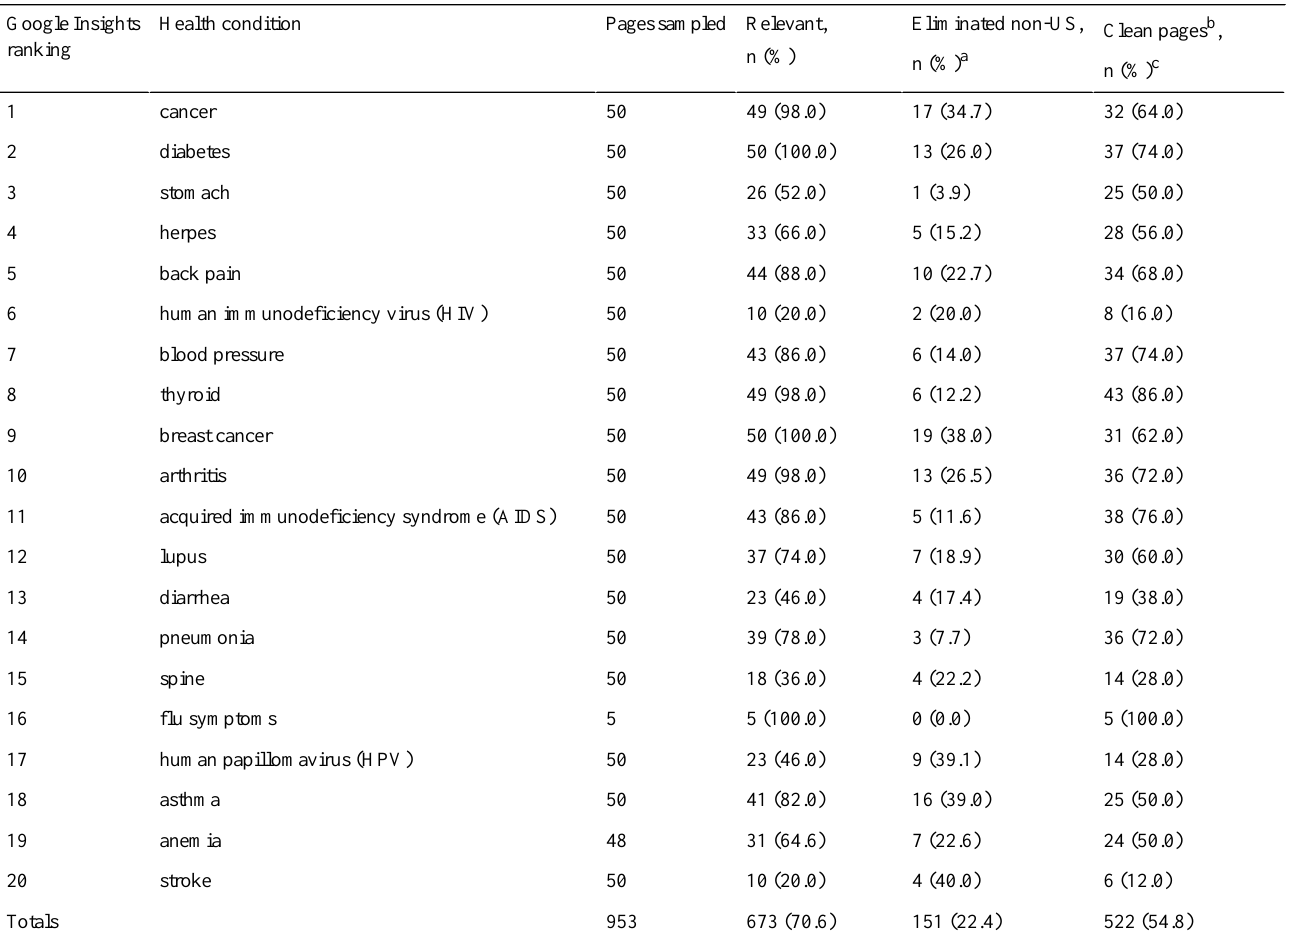
Table 3. Relevant Facebook